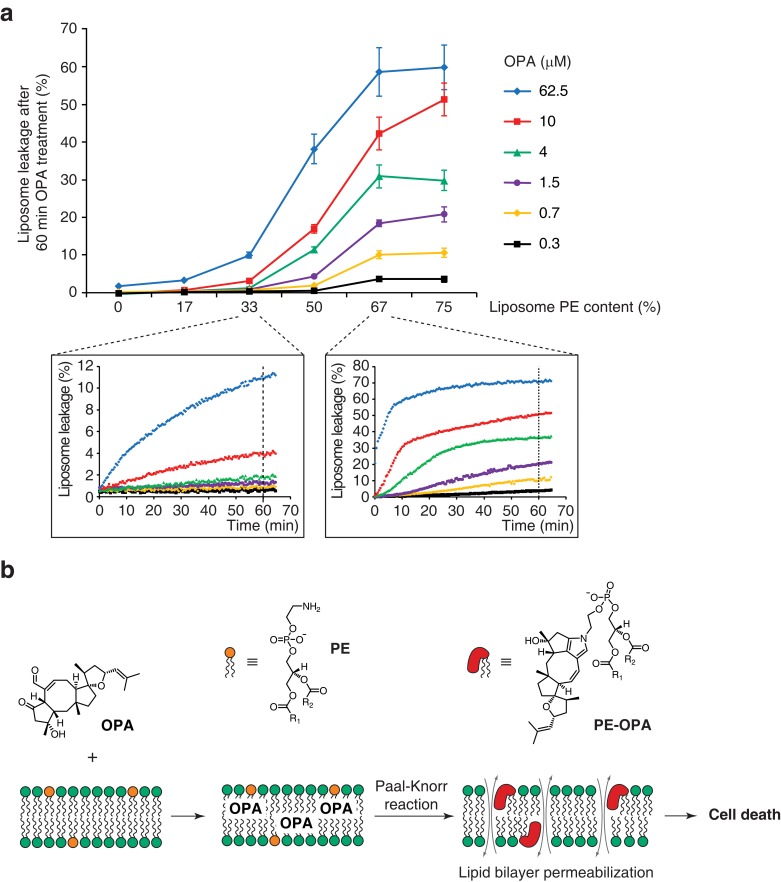
Ophiobolin A (OPA) induces leakage from liposomes.(a) Effect of 60 min OPA treatment on the leakage of the fluorescent dye calcein from artificial liposomes composed of various ratios of phosphatidylethanolamine (PE) to phosphatidylcholine (PC). Large unilamellar vesicles (LUVs) composed of dioleoyl-PE and dioleoyl-PC, and encapsulating calcein were prepared by extrusion. Leakage assays were initiated by addition of OPA and were monitored by quantification of the fluorescence of calcein, which dequenches upon release from liposomes. OPA-induced liposome leakage was determined by normalization of fluorescence to a DMSO vehicle control (0% leakage) and to detergent-treated liposomes (100% leakage). Results were obtained from assays performed in triplicate and data represent mean values ± standard error of the mean. Inset plots display examples of the kinetics of leakage after OPA addition for two liposome preparations. (b) Proposed model of the mechanism of action of OPA in human cells. When applied to cells, OPA accumulates in the phospholipid bilayer of the plasma membrane as it is a lipophilic compound. Due to high local concentrations or the hydrophobic environment (or both), OPA efficiently reacts with the primary amine head group of phosphatidylethanolamine (PE) in a Paal-Knorr-like reaction. Formation of PE-OPA adducts changes the biophysical properties of PE by modifying its head group from small and polar to bulky and hydrophobic, leading to membrane permeabilization and ultimately cell death.